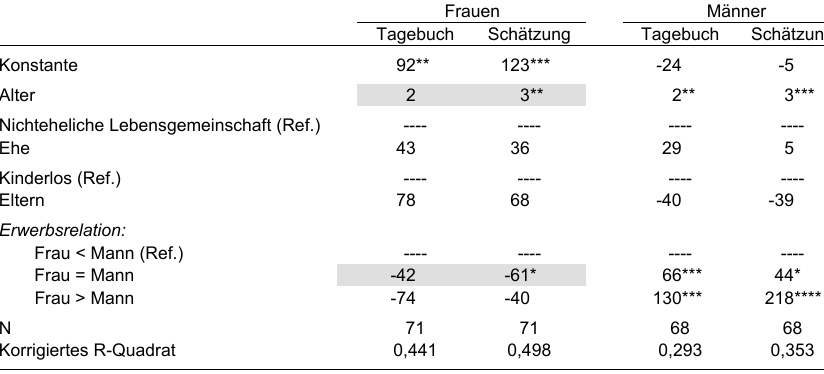
Tabelle 3: Multiple lineare Regression der Gesamtzeit für Hausarbeit – Erwerbsrelation